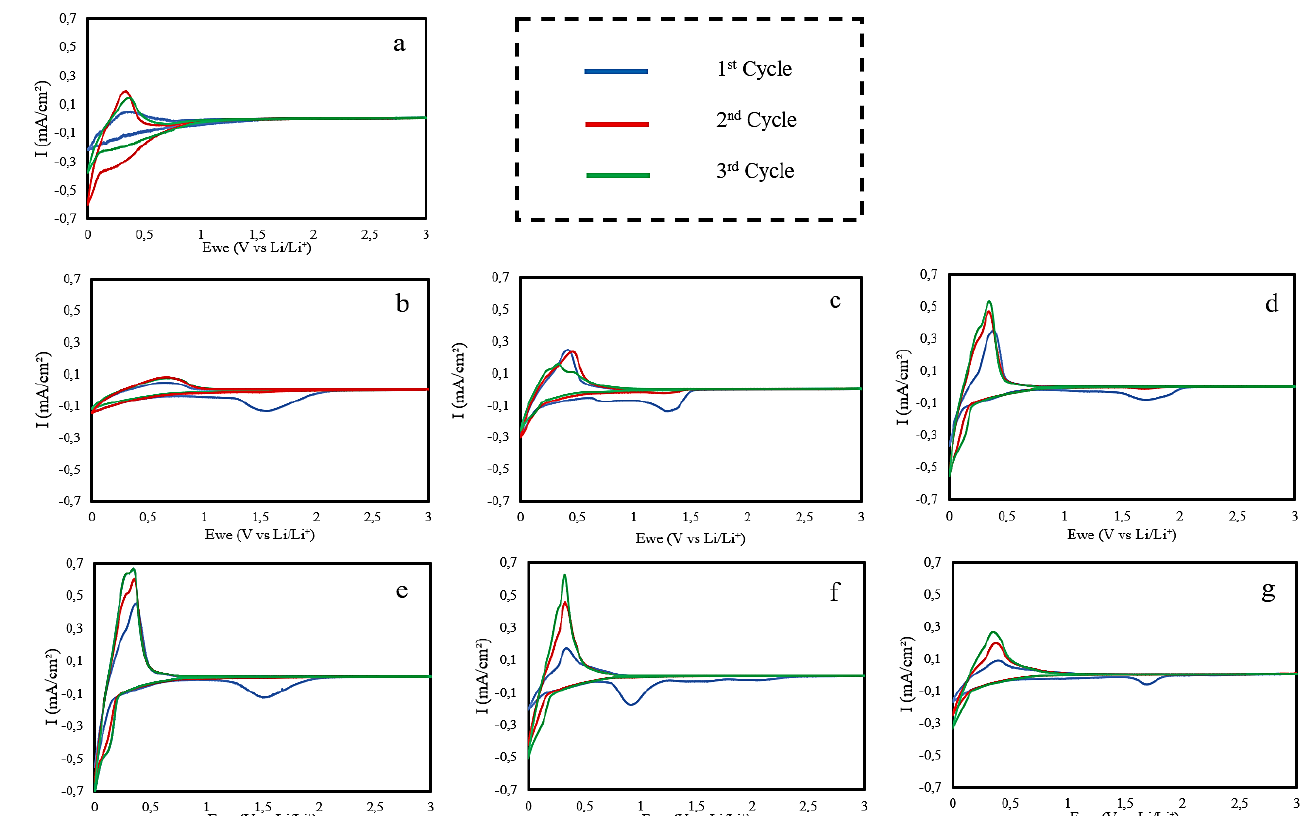
Figure 4. Comparing the CV plots of the base electrolyte without SEI-forming compounds ( a ) with those containing 1%w of CIAC ( b ), MECI ( c ), CICL ( d ), CRAC ( e ), MECR ( f ), and CRCL ( g ). CIAC ( b ), MECI ( c ), CICL ( d ), CRAC ( e ), MECR ( f ), and CRCL ( g